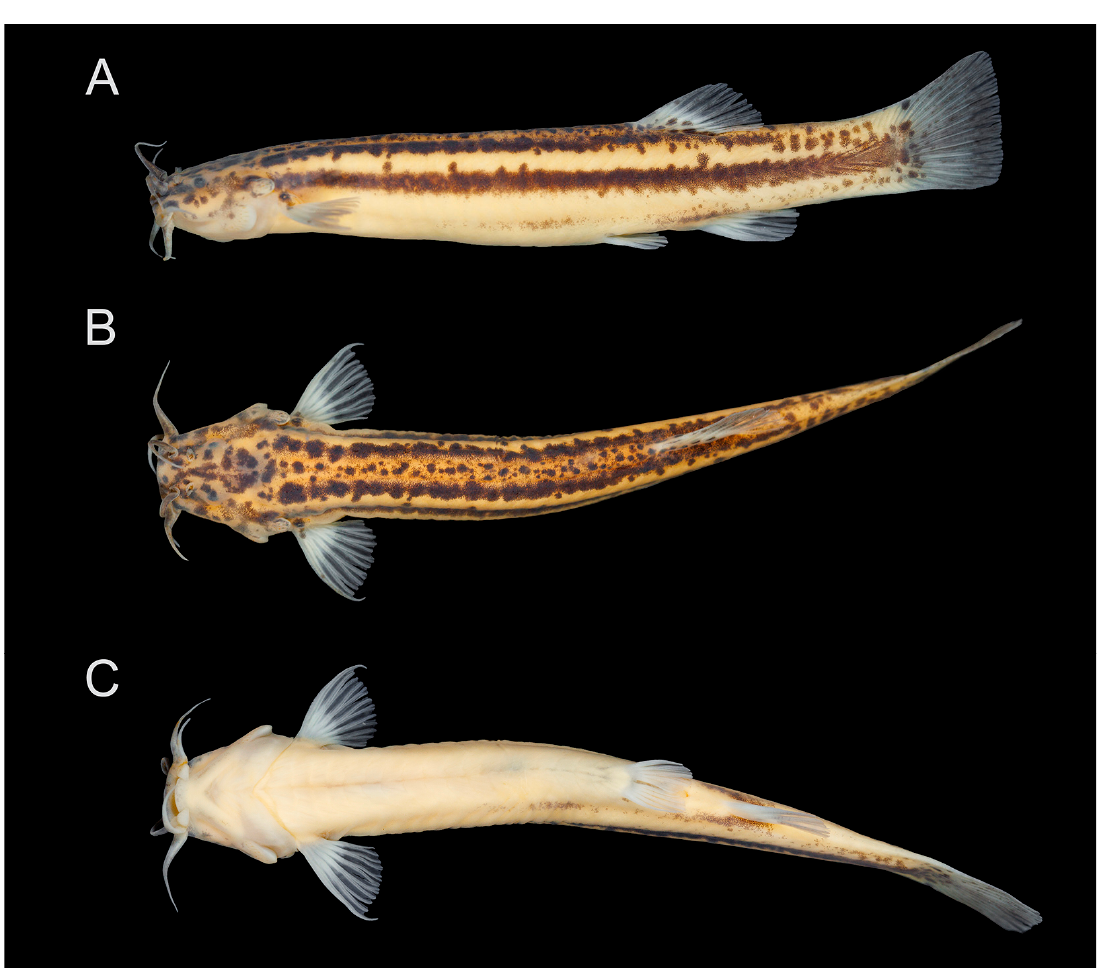
Figure 14. Trichomycterus ( Paracambeva ) coelhorum Costa, Azevedo-Santos & Katz sp. nov. Holotype, UFRJ 13410, Veríssimo, 44.8 mm SL: ( A ) lateral, ( B ) dorsal, and ( C ) ventral views. Holotype. UFRJ 13410, 44.8 mm SL; Brazil: Minas Gerais State: Veríssimo Municipality: stream tributary of Rio Uberaba, Rio Grande drainage, upper Rio Paraná basin, 19°39 ′ 21 ′′ S 48°15 ′ 21 ′′ W, at about 665 m asl; V. M. de Azevedo Santos et al., 15 April 2022. Paratypes. UFRJ 12916, 5 ex., 30.7–39.3 mm SL; UFRJ 12961, 3 ex., 34.9–38.8 mm SL (C&S); CICCAA 07650, 4 ex., 32.2–36.8 mm SL; collected with holotype. Diagnosis . Trichomycterus coelhorum is distinguished from all other congeners of Paracambeva by having fewer dorsal procurrent caudal-fin rays (10–12 vs. 13–25). Trichomycterus coelhorum is also distinguished from all other congeners of Paracambeva , ex- cept for T. humboldti Costa & Katz, 2021, Trichomycterus pauciradiatus Alencar & Costa, 2006, Trichomycterus piratymbara Katz, Barbosa & Costa, 2013, T. reinhardti , and T. sainthilairei , by having six pectoral-fin rays. Trichomycterus coelhorum differs from T. humboldti , T. pauciradiatus , T. piratymbara , T. reinhardti , and T. sainthilairei by having fewer ventral procurrent caudal- fin rays (9 or 10 vs. 11–18); from T. piratymbara , T. reinhardti , and T. sainthilairei by having fewer vertebrae (34–36 vs, 37–40); from T. piratymbara , T. humboldti , and T. pauciradiatus by having fewer ribs (12–14 vs. 15–19); and from T. humboldti and T. pauciradiatus by having five pelvic-fin rays (vs.